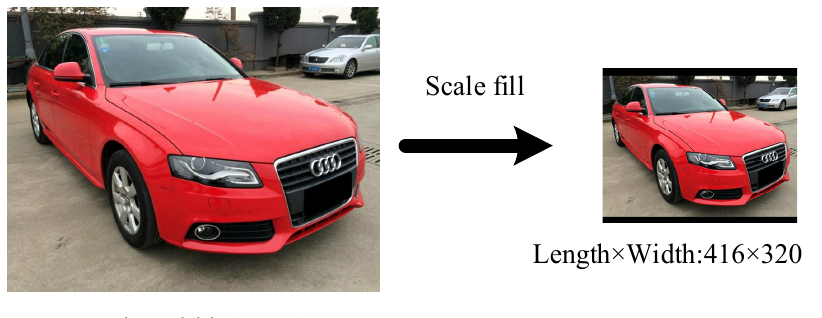
Figure 4. Size drawing after scaling.